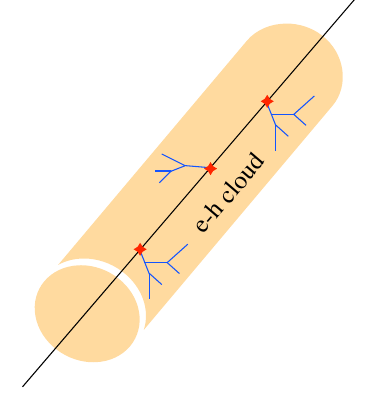
FIG. 11. Schematic depiction of the creation of e − h þ pairs by a track, shown as a black line, as it passes through a material. Hard scatters of the track, shown by the red stars, create secondary energetic electrons that subsequently create more e − h þ pairs. The secondary electrons and e − h þ pairs are represented by the blue lines, and the cloud that they form is represented in yellow.